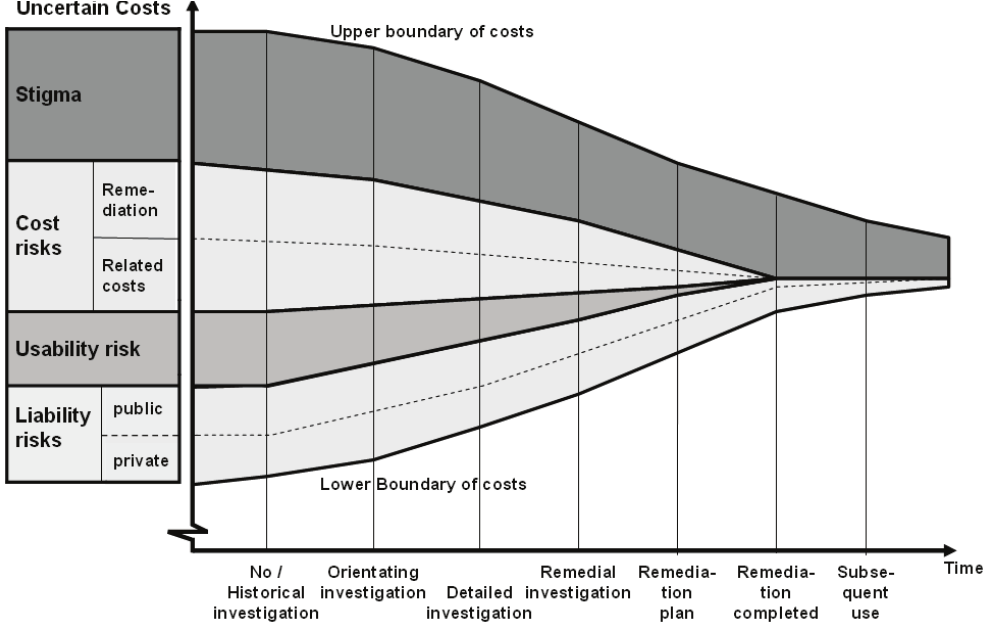
figure 2. Components and time dependence of mercantile Value